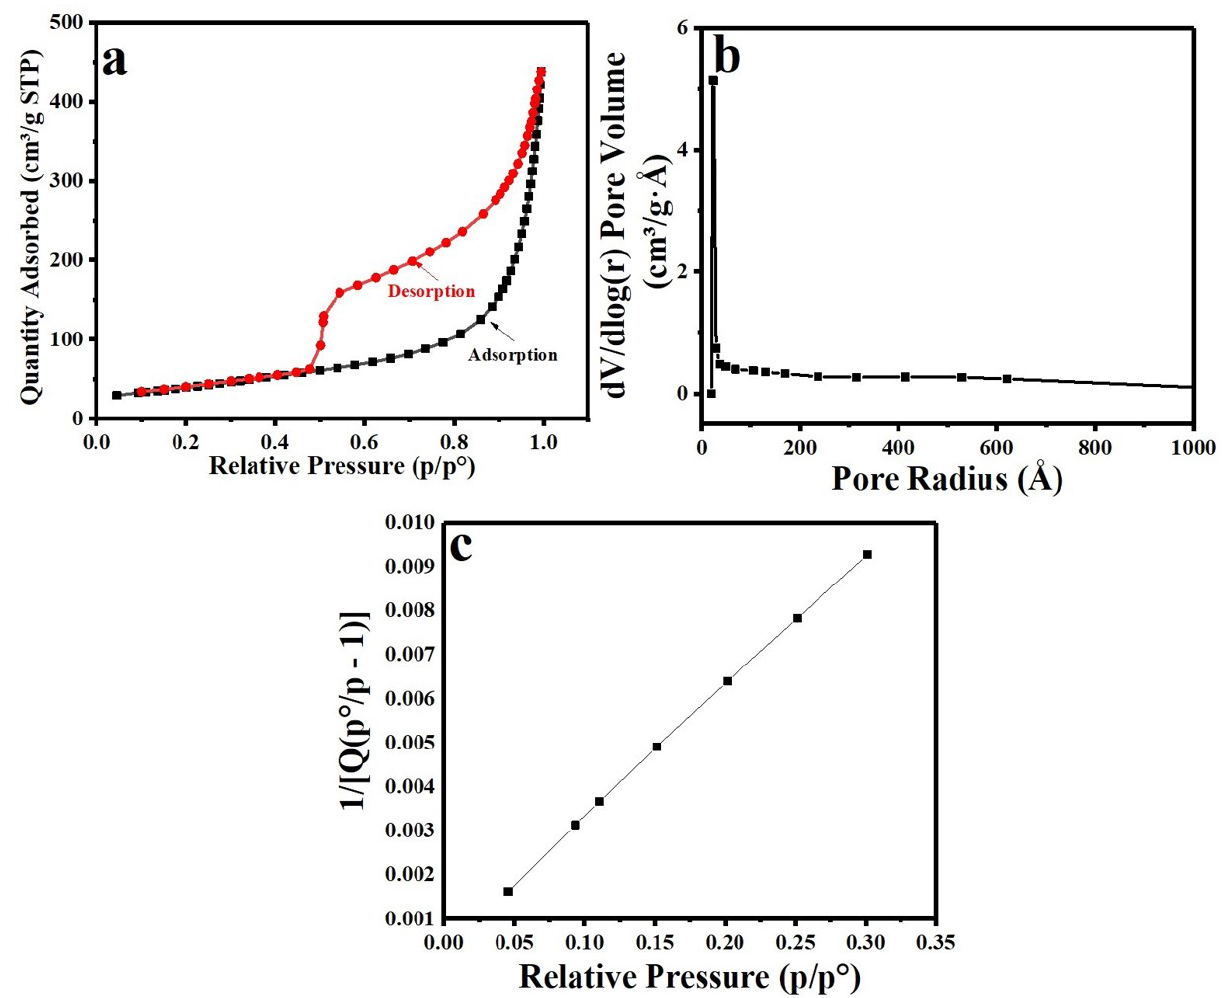
Figure 5: (a) N 2 adsorption–desorption isotherm and (b) BJH pore size distribution of the synthesized Se-nanorods/rGO nanocomposite